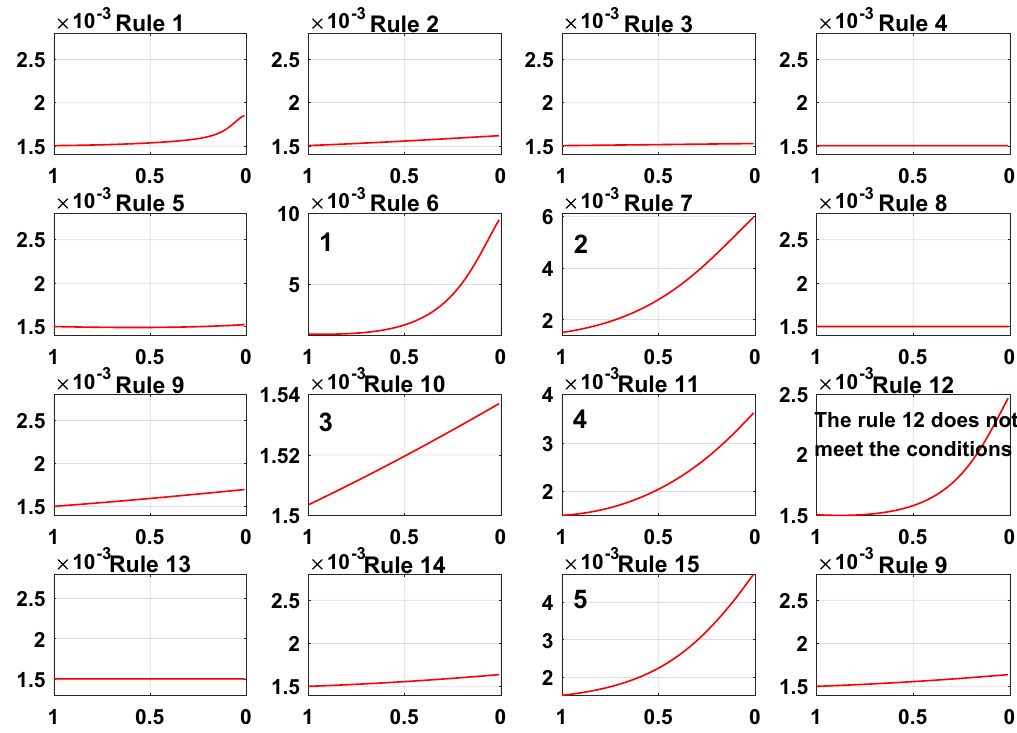
Figure 10. The sensitivity analysis for Sub-BRB2 (x-axis represents rule weights, y-axis represents